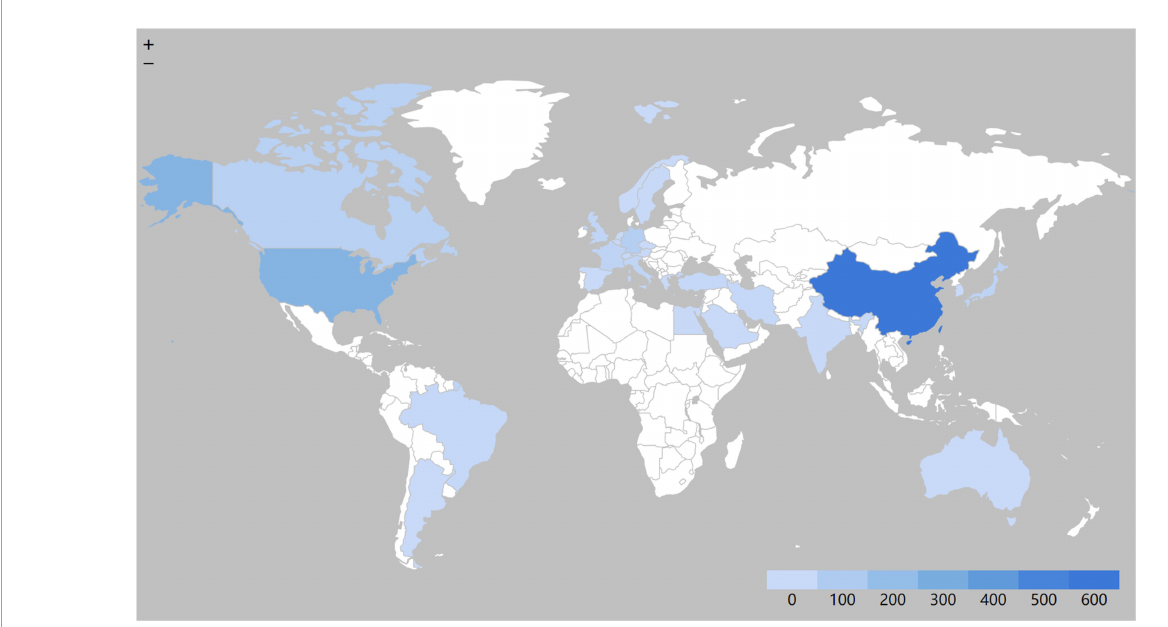
FIGURE3 The distribution map of countries/regions.